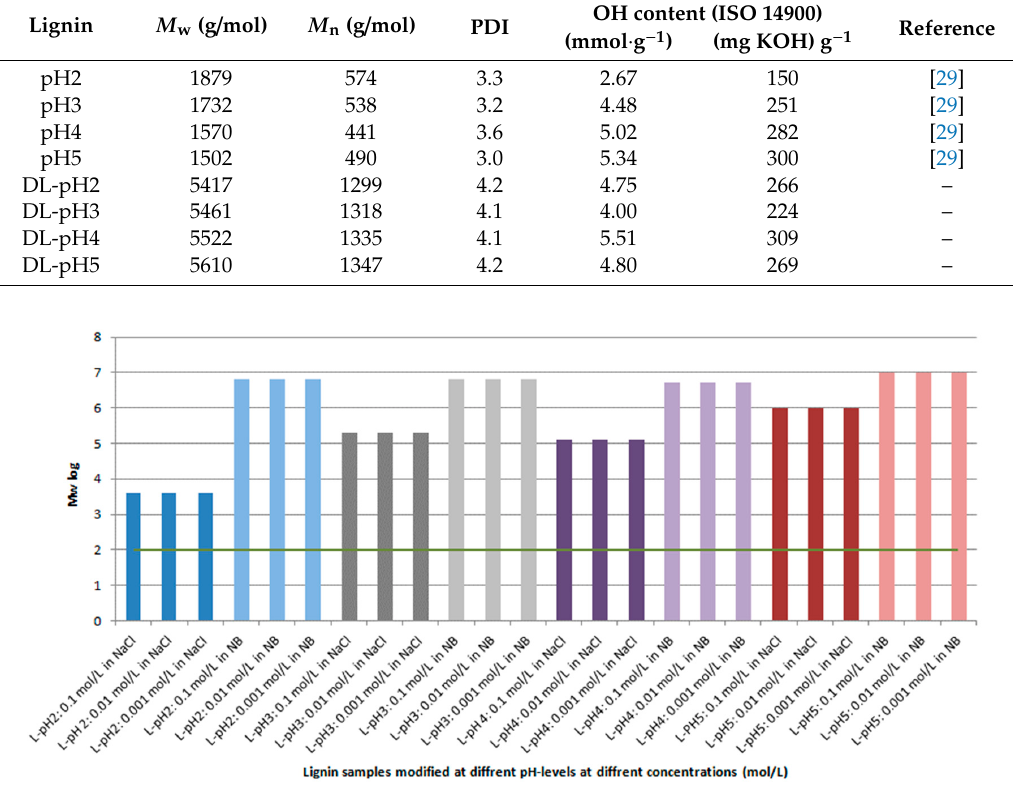
Figure 2. Antimicrobial activity of unmodified Kraft lignins isolated at different pH levels (varying from 2 to 5). Activity tested against Staphylococcus aureus in NaCl and physiological saline solution (NB)), respectively, in concentrations ranging between 0.1–0.001 mol/L.